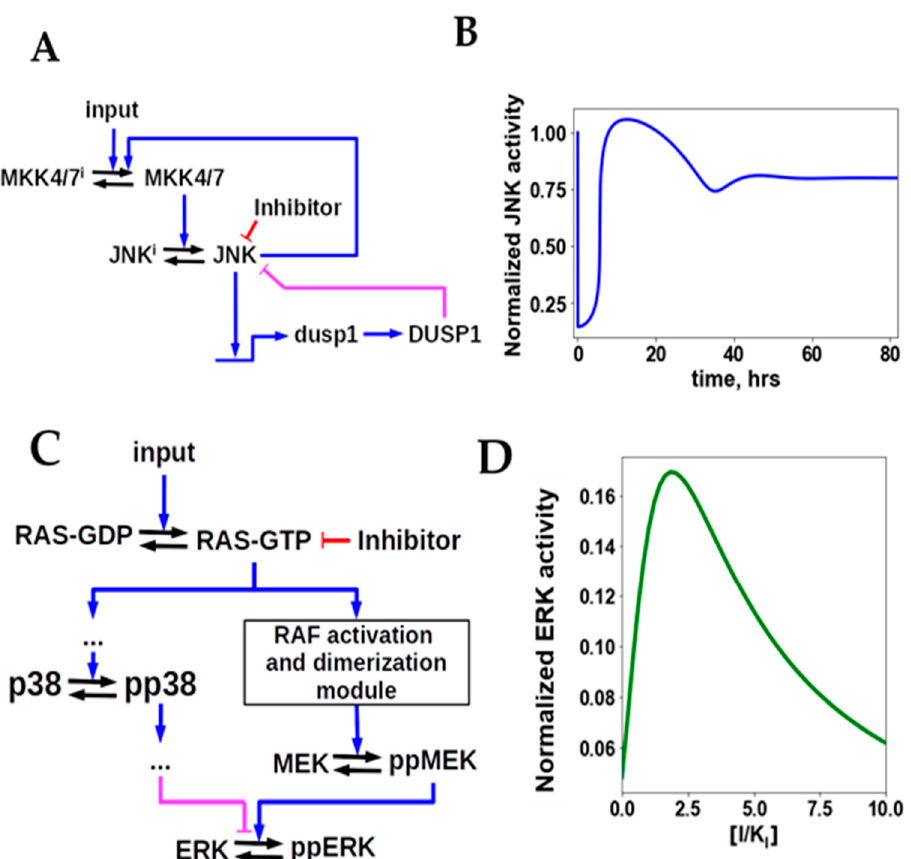
Figure 4. Feedback loops cannot completely reactivate steady-state output signaling and network adaptations that can fully restore or increase it. ( A ) A simplified diagram of the JNK/MAPK pathway featuring negative transcriptional feedback via the induced phosphatase (DUSP) synthesis and positive phosphorylation-mediated feedback loops. ( B ) The time course of the JNK activity after the JNK inhibitor treatment. A transient reactivation period and overshoot is followed by the decrease in the steady-state JNK activity. ( C , D ) Two feedforward connections, positive and negative, can lead to complete signaling reactivation. ( C ) Positive and negative feedforward routes from RAS to ERK mediated by RAF/MEK and the p38 pathway, respectively. ( D ) Dose response curve shows paradoxical activation of ERK by inhibitor ( 𝐼 ) within a certain dose range.